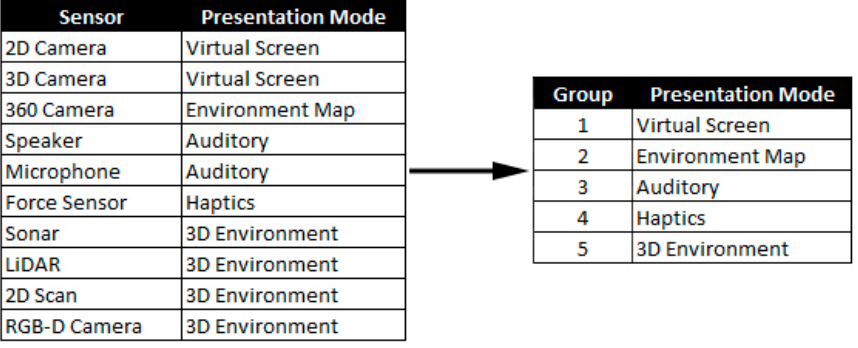
Figure 7. Grouping Sensor Types into sensor presentation groups using rules determined in this work.